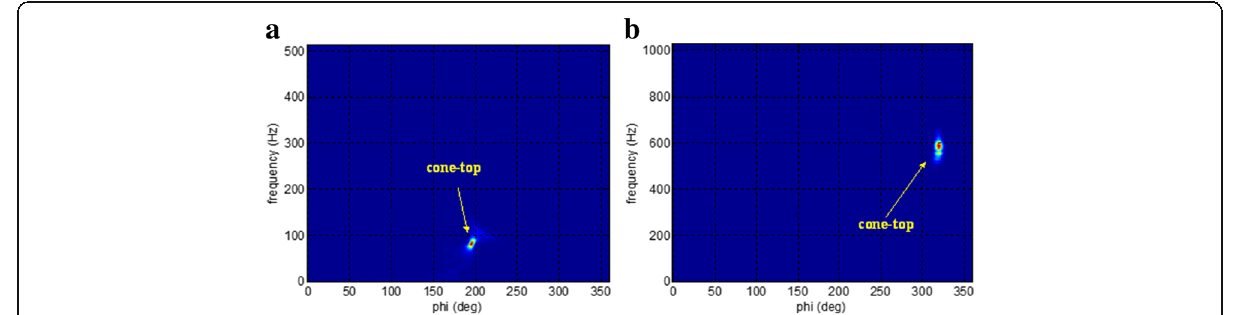
Fig. 15 Parameter spaces. a The non-aliasing situation. b The aliasing